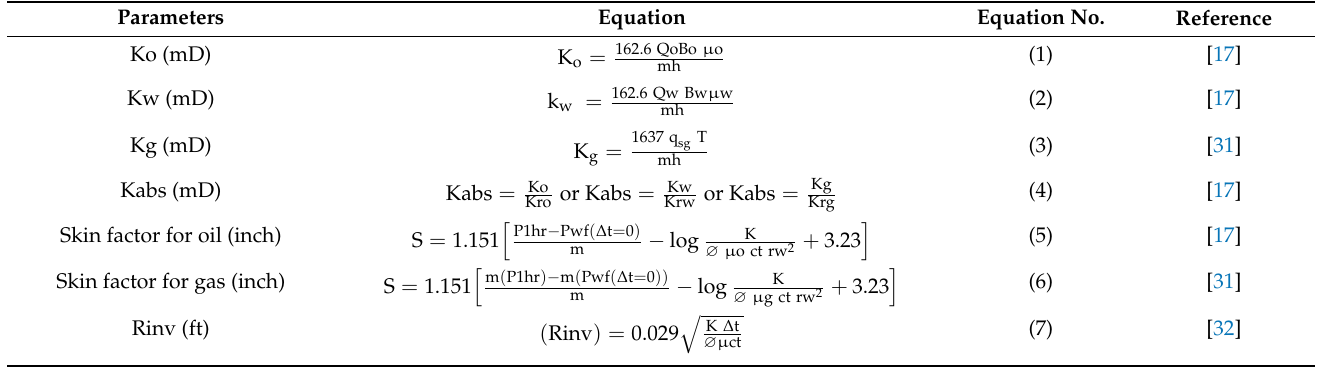
Table 3. A list of pressure transient equations used in the present calculations. Parameters